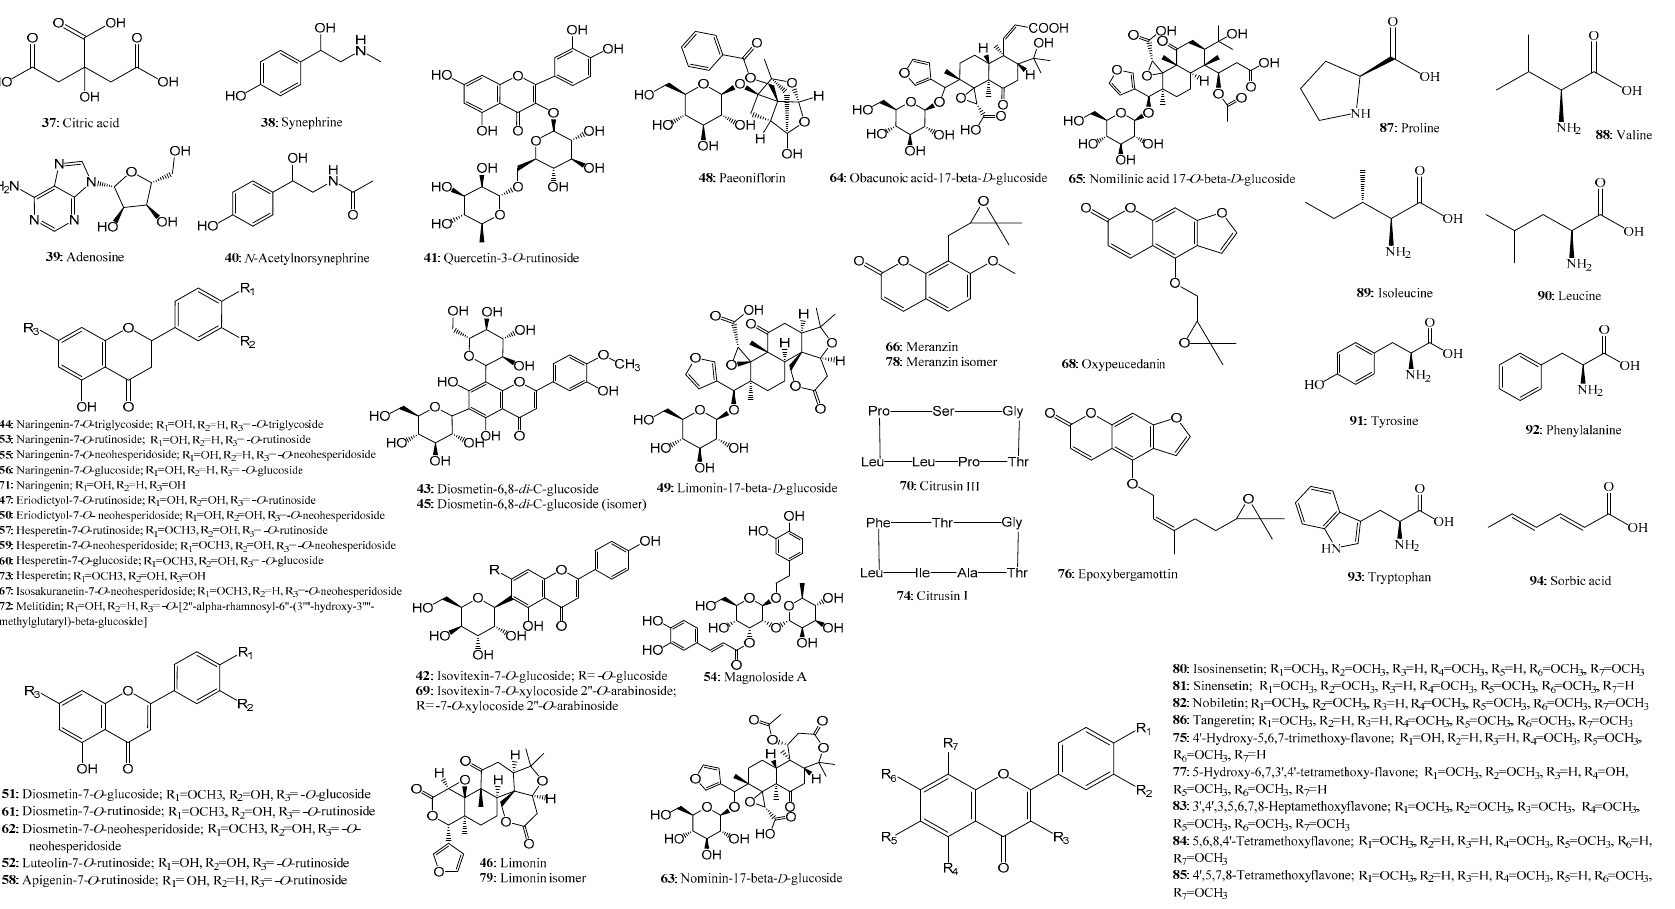
Figure 3. The compounds were identified or preliminarily assigned from Simo decoction (SMD) based on the time-of flight-mass spectrometer.